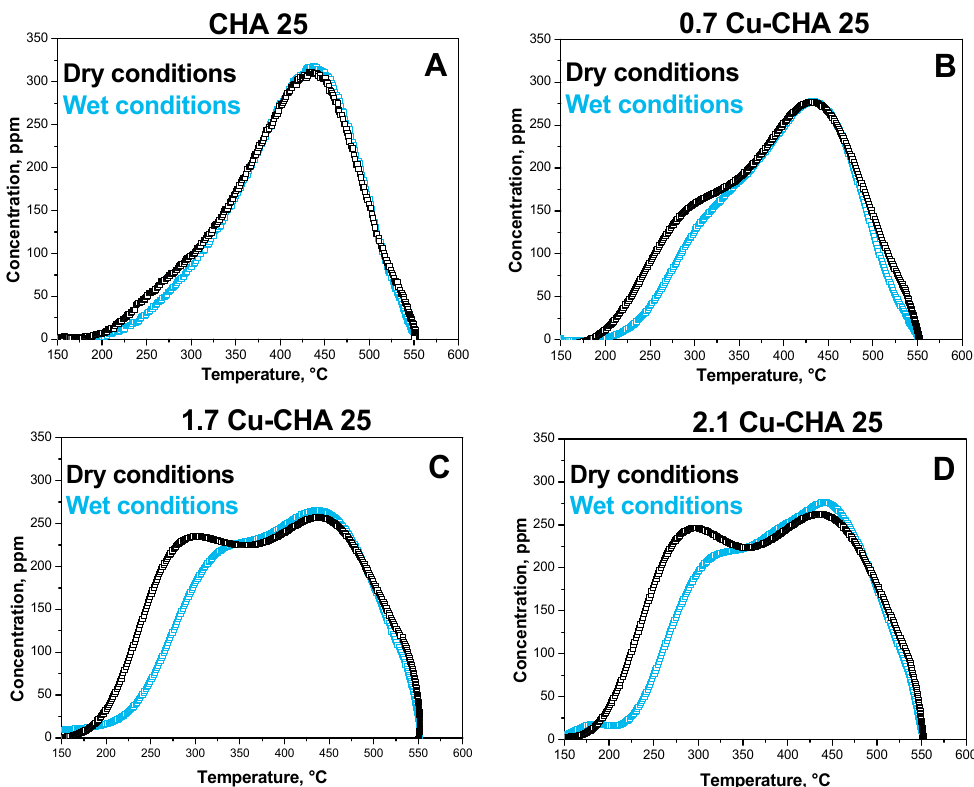
Figure 3. Comparison between dry and wet NH 3 -TPD (NH 3 + 2N 2 ) after adsorption at 150 °C on Cu-CHA catalysts with SAR = 25 and different Cu loadings: ( A ) 0% w / w ; ( B ) 0.7% w / w ; ( C ) 1.7% w / w ; ( D ) 2.1% w / w . NH 3 = 500 ppm, H 2 O = 0–5% v / v ; heating rate = 15 °C/min, He. GHSV = 266,250 cm 3 /(g cat *h) (STP). Pre-oxidized catalysts.